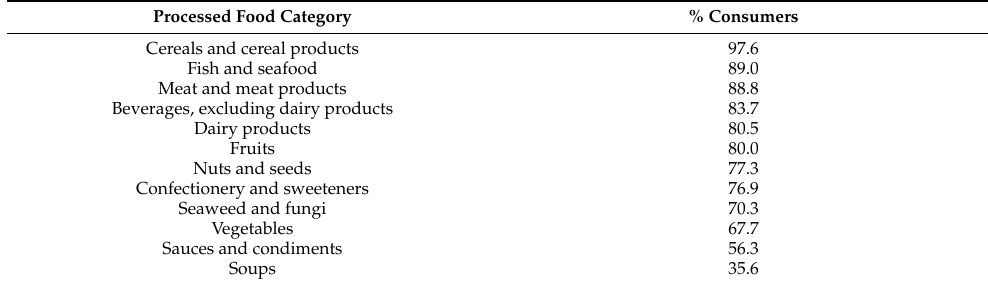
Table 2. Proportion of consumers of each food category.